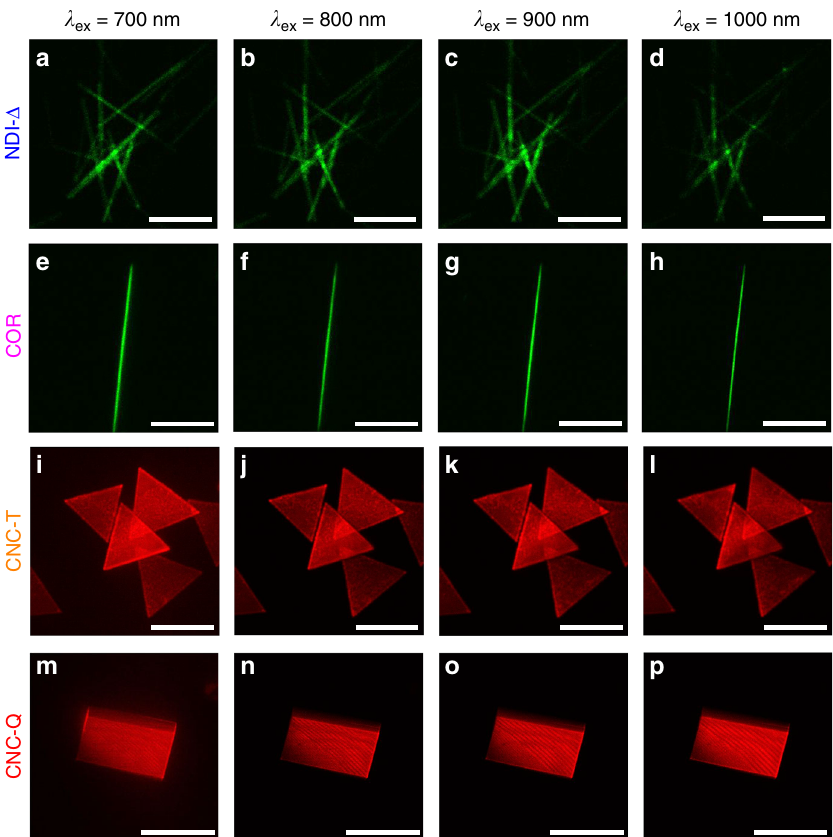
Fig. 6 Photon upconversion characteristics. Two-photon microscopy images of a − d NDI- Δ , e − h COR , i − l CNC-T and m − p CNC-Q . a − d The excitation laser powers for NDI- Δ crystals were 7.0, 30.4, 54.0, and 54.0 mW, respectively. Scale bar: 20 μ m. e − h The excitation laser powers for COR crystal were 6.7, 37.1, 72.0, and 54.0mW, respectively. Scale bar: 100 μ m. i − l The excitation laser powers for CNC-T were 6.3, 8.1, 3.5, and 2.7 mW, respectively. Scale bar: 40 μ m. m − p The excitation laser powers for CNC-Q were 3.0, 3.8, 1.6, and 1.1 mW, respectively. Scale bar: 100 μ